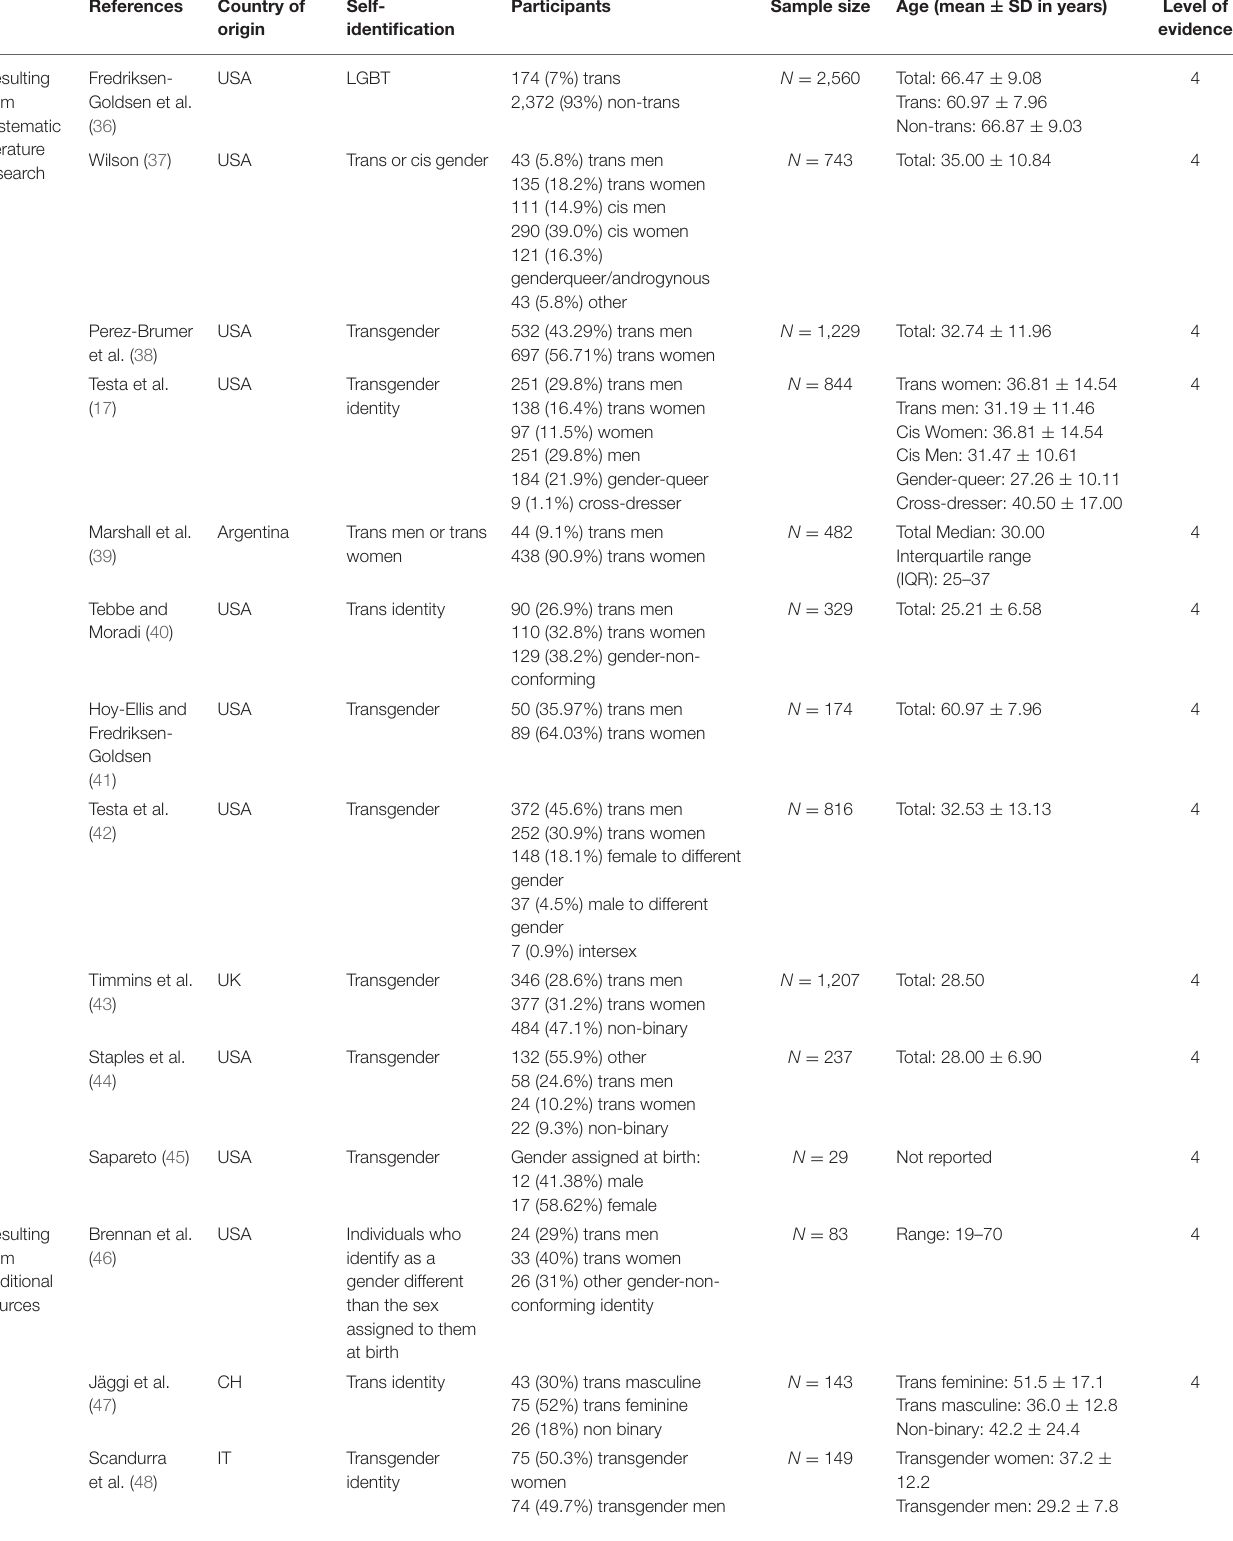
Trans feminine: 51.5 ± 17.1 Trans masculine: 36.0 ± 12.8 Non-binary: 42.2 ± 24.4 Transgender women: 37.2 ± 12.2 Transgender men: 29.2 ±